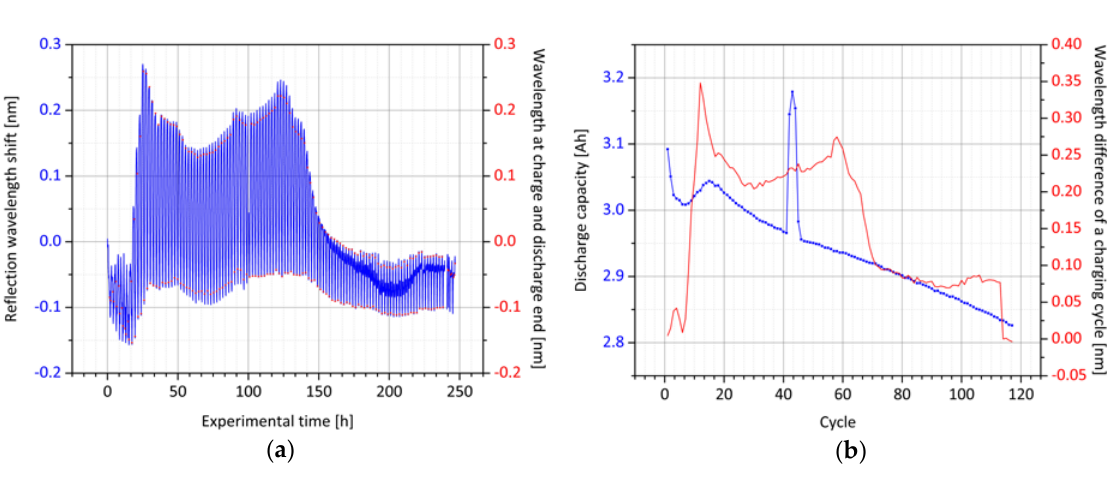
Figure 11. Optical signal of the surface Bragg grating between the separator layers: ( a ) Shown is the recorded reflection wavelength shift of the optical sensor during cell cyclization. The wavelength at the end of both the charge and the discharge is detected by the evaluation program; ( b ) the wavelength difference between the end of the charge and discharge cycle, respectively, is plotted along with the loss of electrical capacity over the cycle number. Shortly after cycle 40, the charge chamber’s temperature control failed, resulting in increased discharge capacity for four cycles.